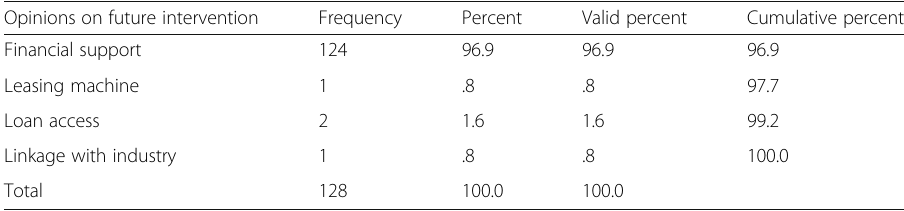
Table 15 Areas of intervention